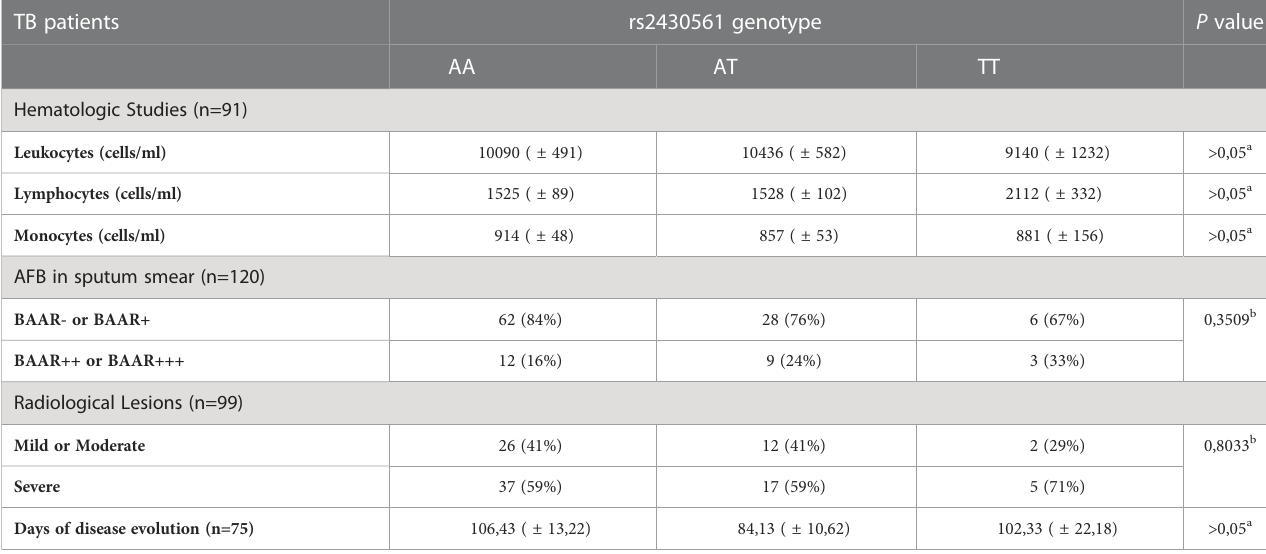
TABLE 4 Association between clinical parameters and the rs2430561 SNP genotypic variants during active